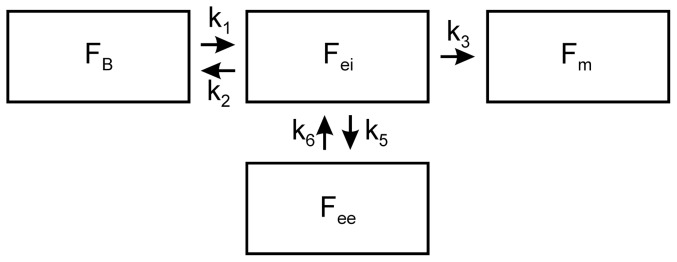
Four-Compartment Model.Schematic of the lung-specific four-compartment model of 18F-FDG kinetics including an extra-vascular extra-cellular compartment to account for 18F-FDG that is not directly available for phosphorylation, such as 18F-FDG in lung water. Note the functional distinction between extra-vascular extra-cellular compartment, which is a non-substrate compartment so that 18F-FDG is not available for phosphorylation, and the precursor compartment where 18F-FDG is available for phosphorylation.